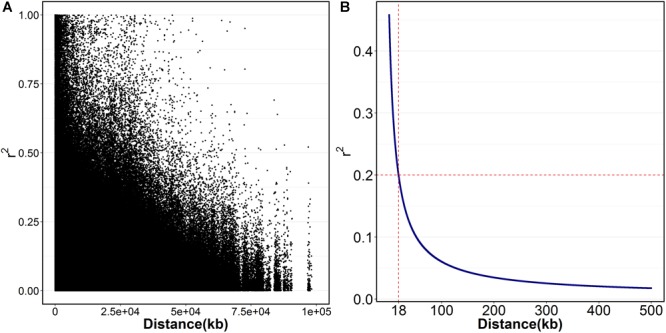
The extent of LD (r2) in Litopenaeus vannamei. (A) The scatter plot of r2 against the physical distance; (B) the fitted decay curve of r2 within 500 kb.